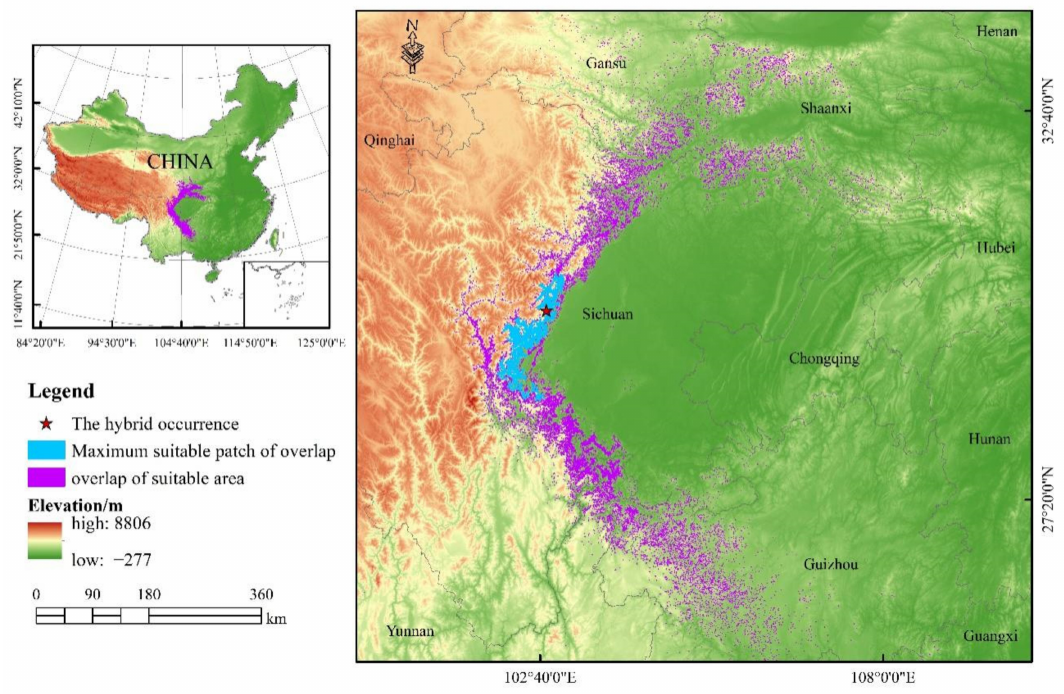
Figure 6. The overlap potential suitable habitat of Chrysolophus